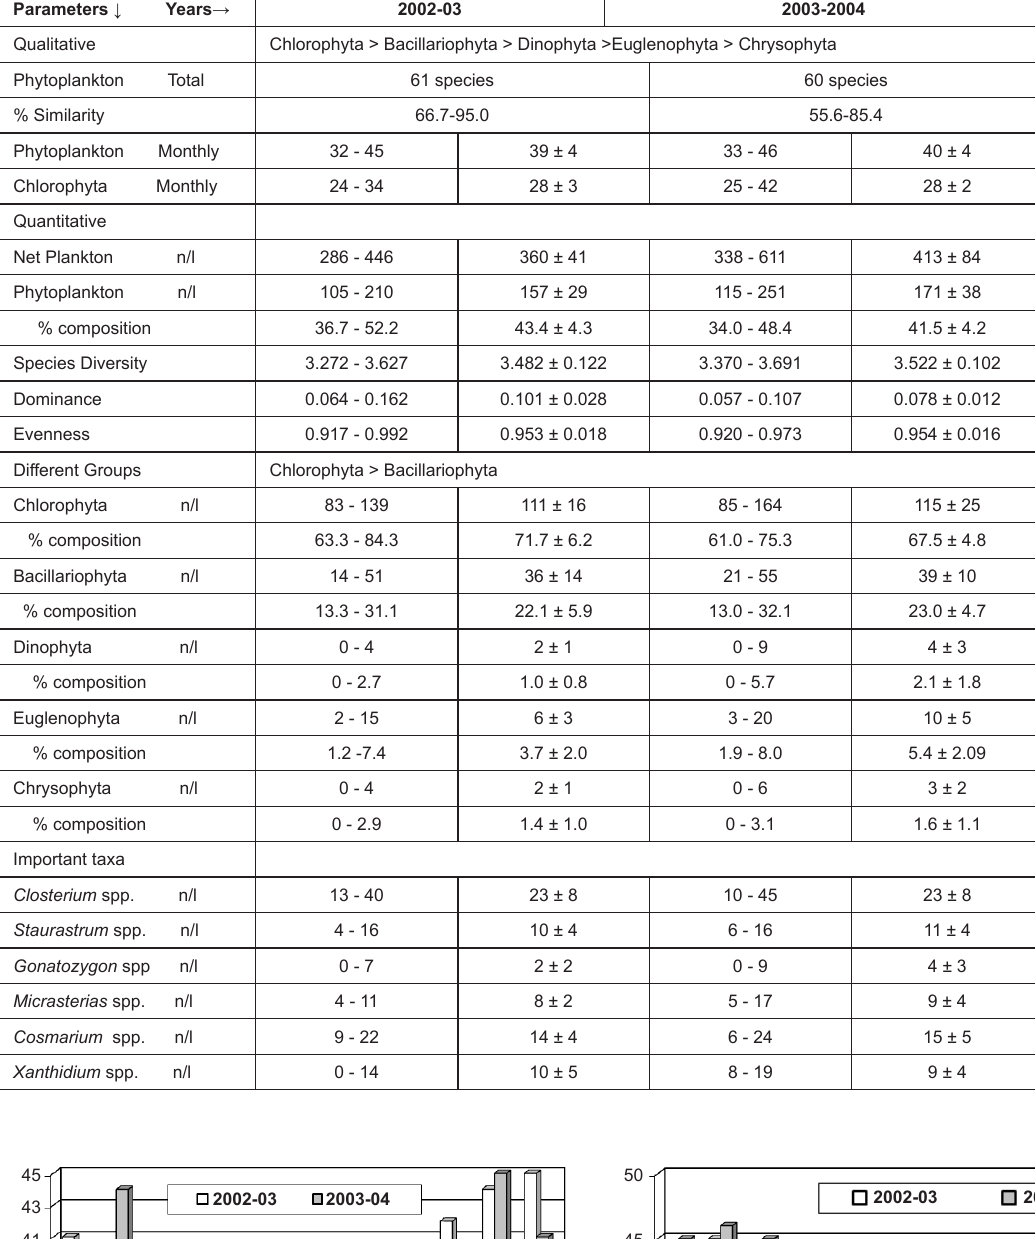
Table 3. Temporal variations of Phytoplankton of Waithou Pat